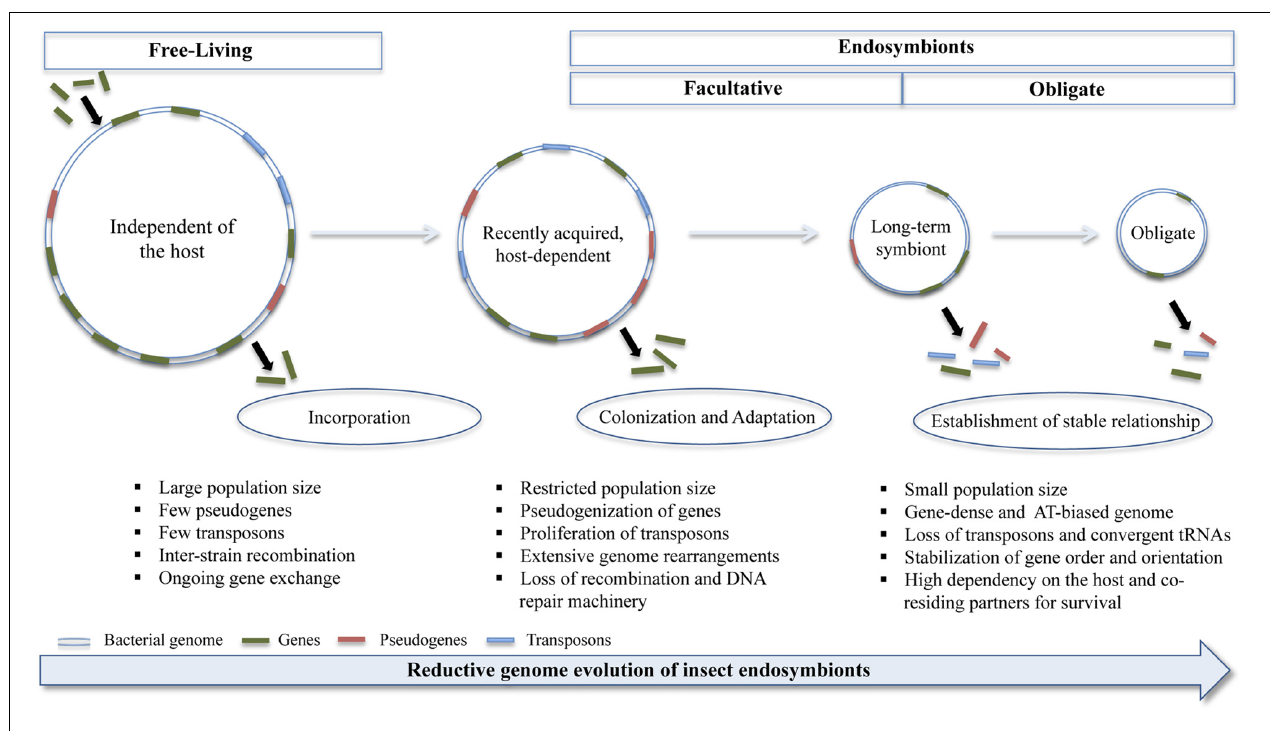
FIGURE 1 | Diagrammatic representation of steps involved in the transition of free-living bacteria to obligate insect endosymbionts. The host-restricted bacteria undergo changes in its genomic size, composition and architecture; and these are brought about by excessive gene loss, chromosomal rearrangements, proliferation of transposons and pseudogenization of several non-essential genes during the adaptation stage and these processes are attenuated on transformation to obligate symbionts (see text for details). Objects in the figure are not drawn to